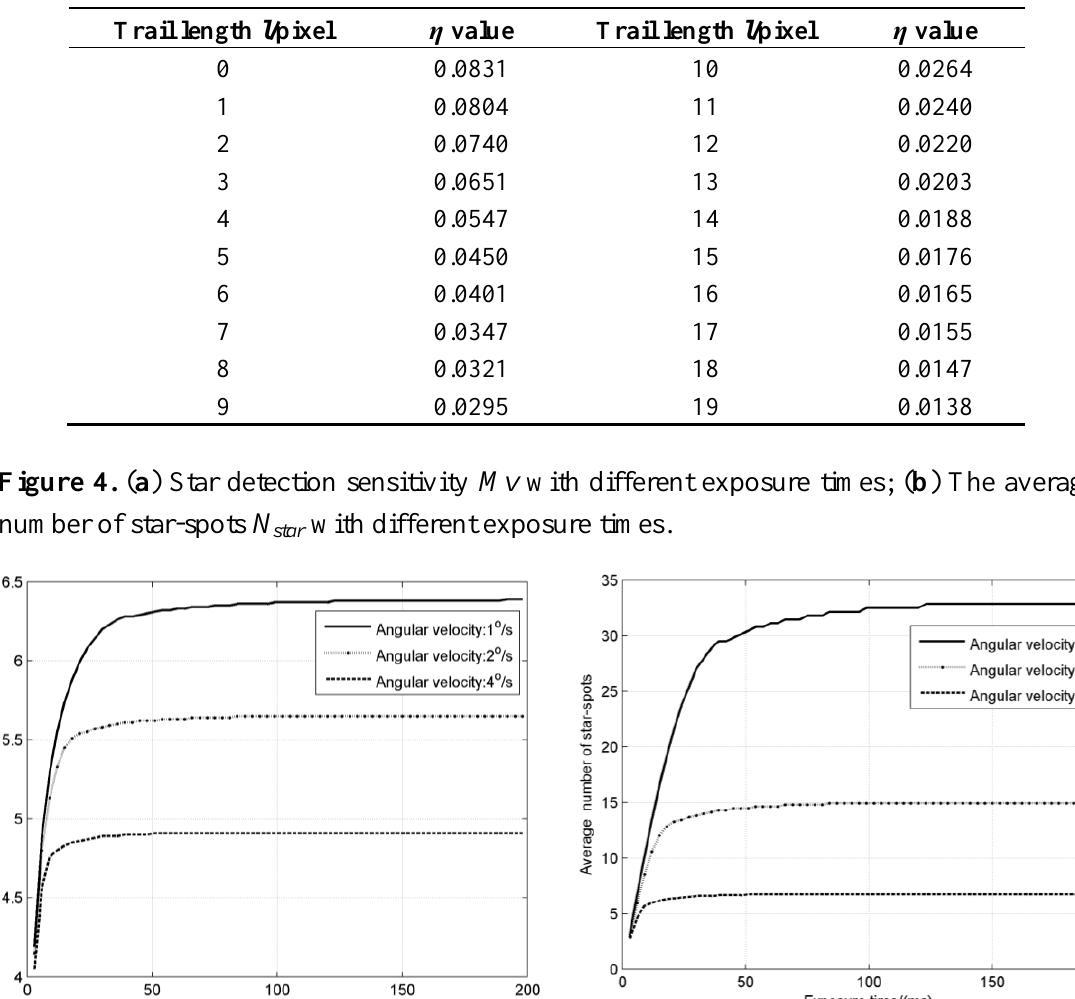
Table 2. η values with different lengths of the star-spot trail.